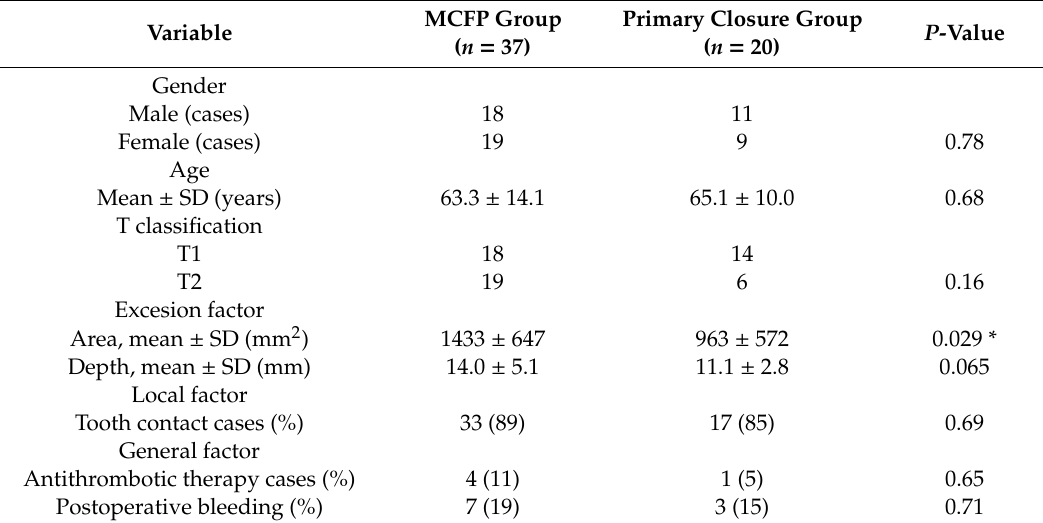
Table 1. Background